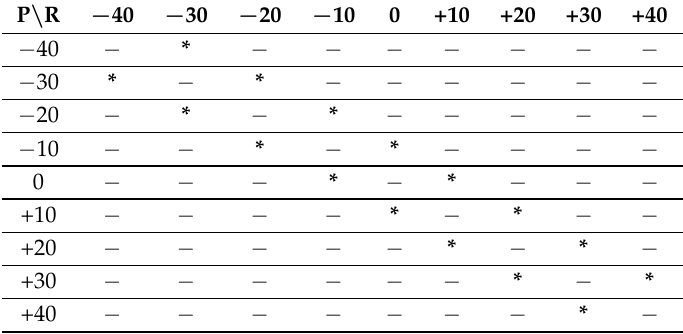
Table 1. The reference (columns) and the probe (rows) sounds from azimuth angles that are used in the tests: (*) conditions are used in the error rate calculations for the azimuth 0, 10, 20, 30 and 40 degrees. Right and left azimuth angles are respectively denoted by positive and negative signs. P \ R −